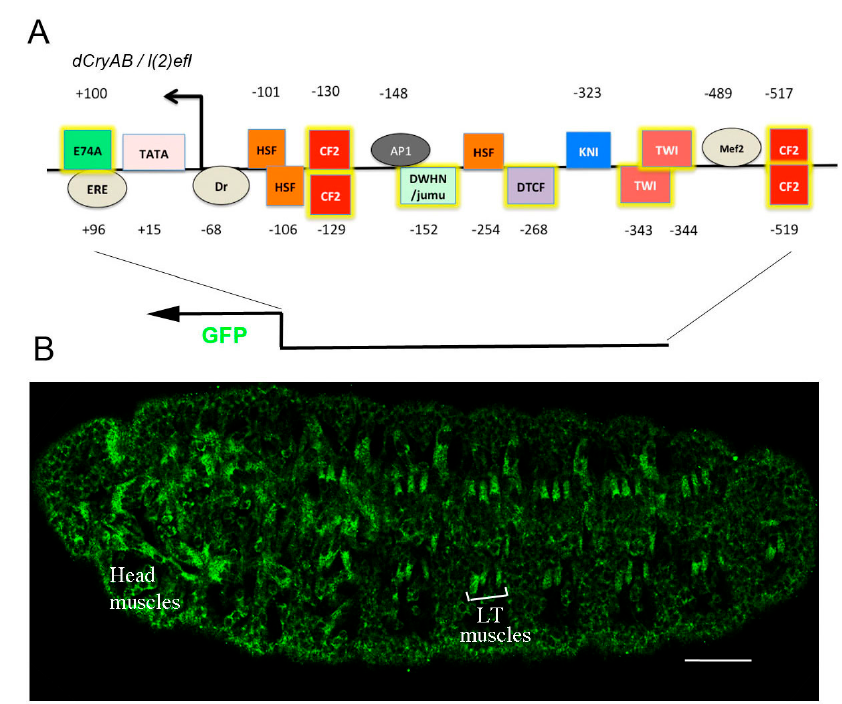
Figure 3. Example of muscle-specific expression of dCryAB. ( A ) dCryAB regulatory region contains several binding sites for muscle/mesoderm transcription factors, including TWI, CF2, and Mef2. Others indicated in the scheme binding sites correspond to E74A—Ecdysone-induced protein 74;